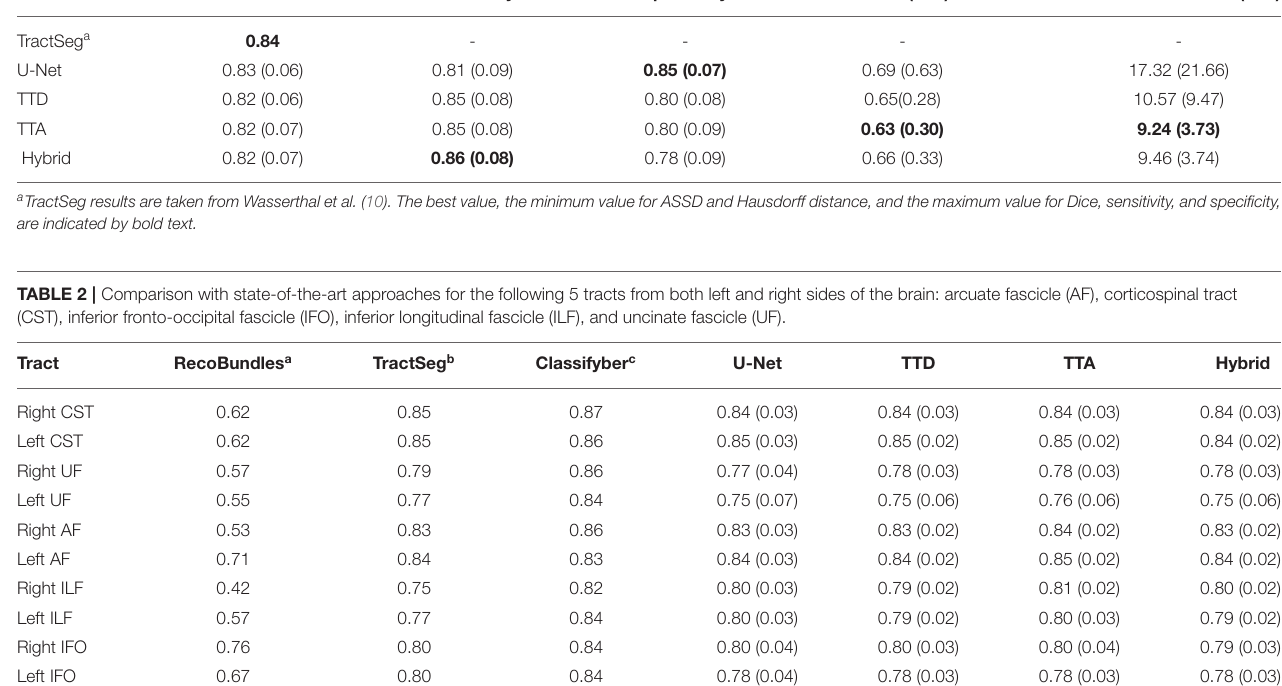
TABLE 1 | Dice, sensitivity, specificity, ASSD, and Hausdorff distance evaluation for deterministic (U-Net) and stochastic (TTD, TTA, and Hybrid) approaches. Network a